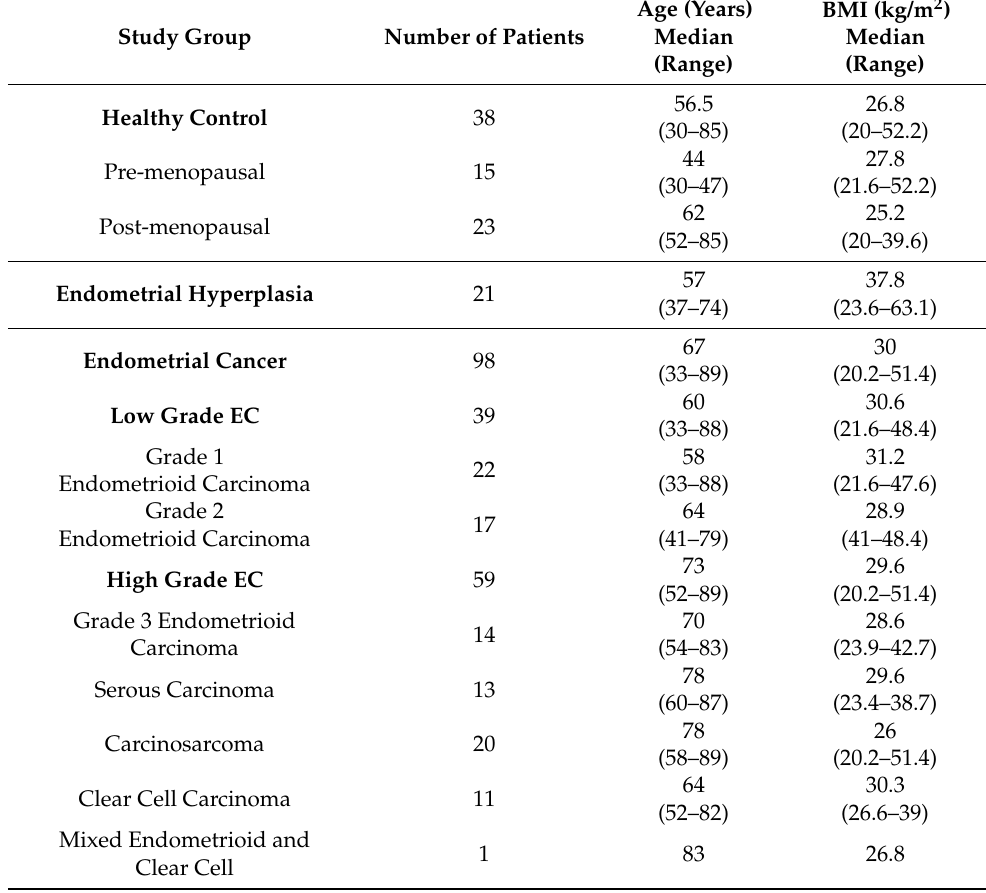
Table 1. Patient demographic features. Age : Pre-menopausal vs. post-menopausal p < 0.0001. Pre-menopausal vs. endometrial hyperplasia p < 0.0001. Pre-menopausal vs. Endometrial Cancer p < 0.0001. Endometrial hyperplasia vs. endometrial cancer p = 0.0007. BMI : Endometrial hyperplasia vs. pre-menopausal p = 0.0061. Endometrial hyperplasia vs. post-menopausal p < 0.0001. Endometrial hyperplasia vs. endometrial cancer p =